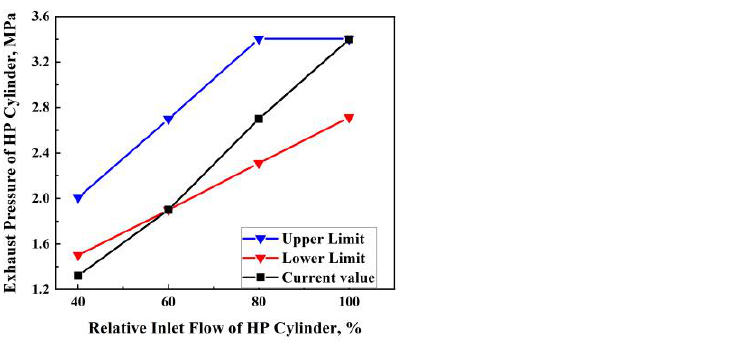
Figure 18. Upper and lower limits on back pressure of HP cylinder, as well as value of back pressure and relative inlet flow in the current simulation .